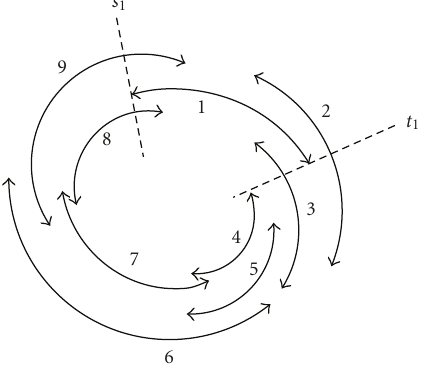
Figure 2: Example of